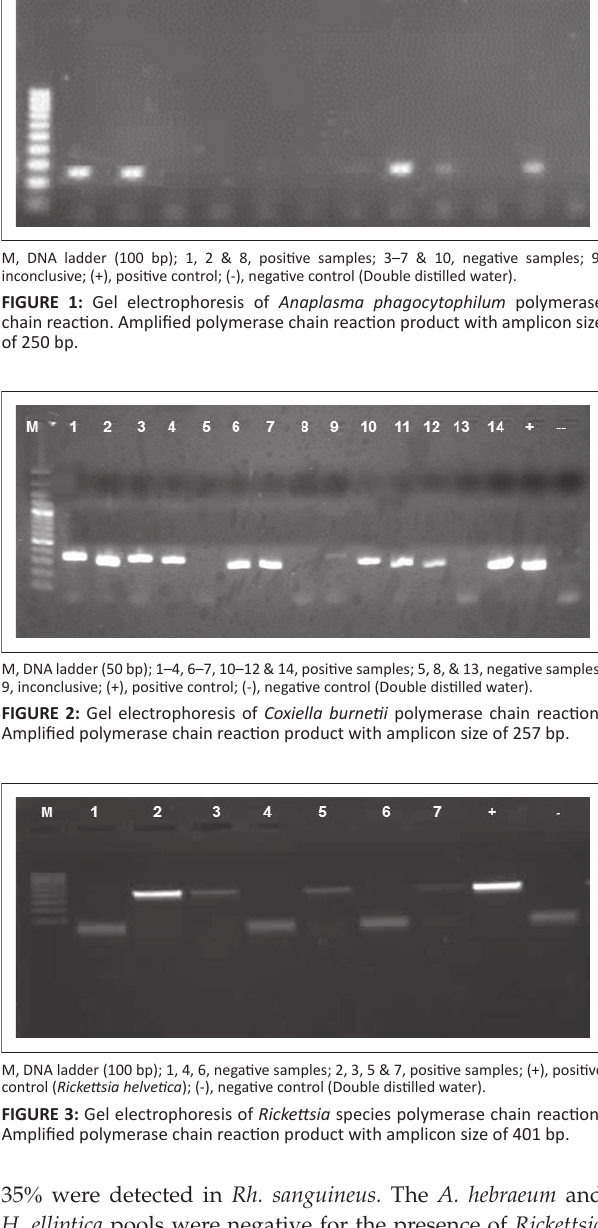
Table 1. Tick samples obtained from cats were all PCR positive for the A. phagocytophilum -like bacterium and none of the other target pathogens.